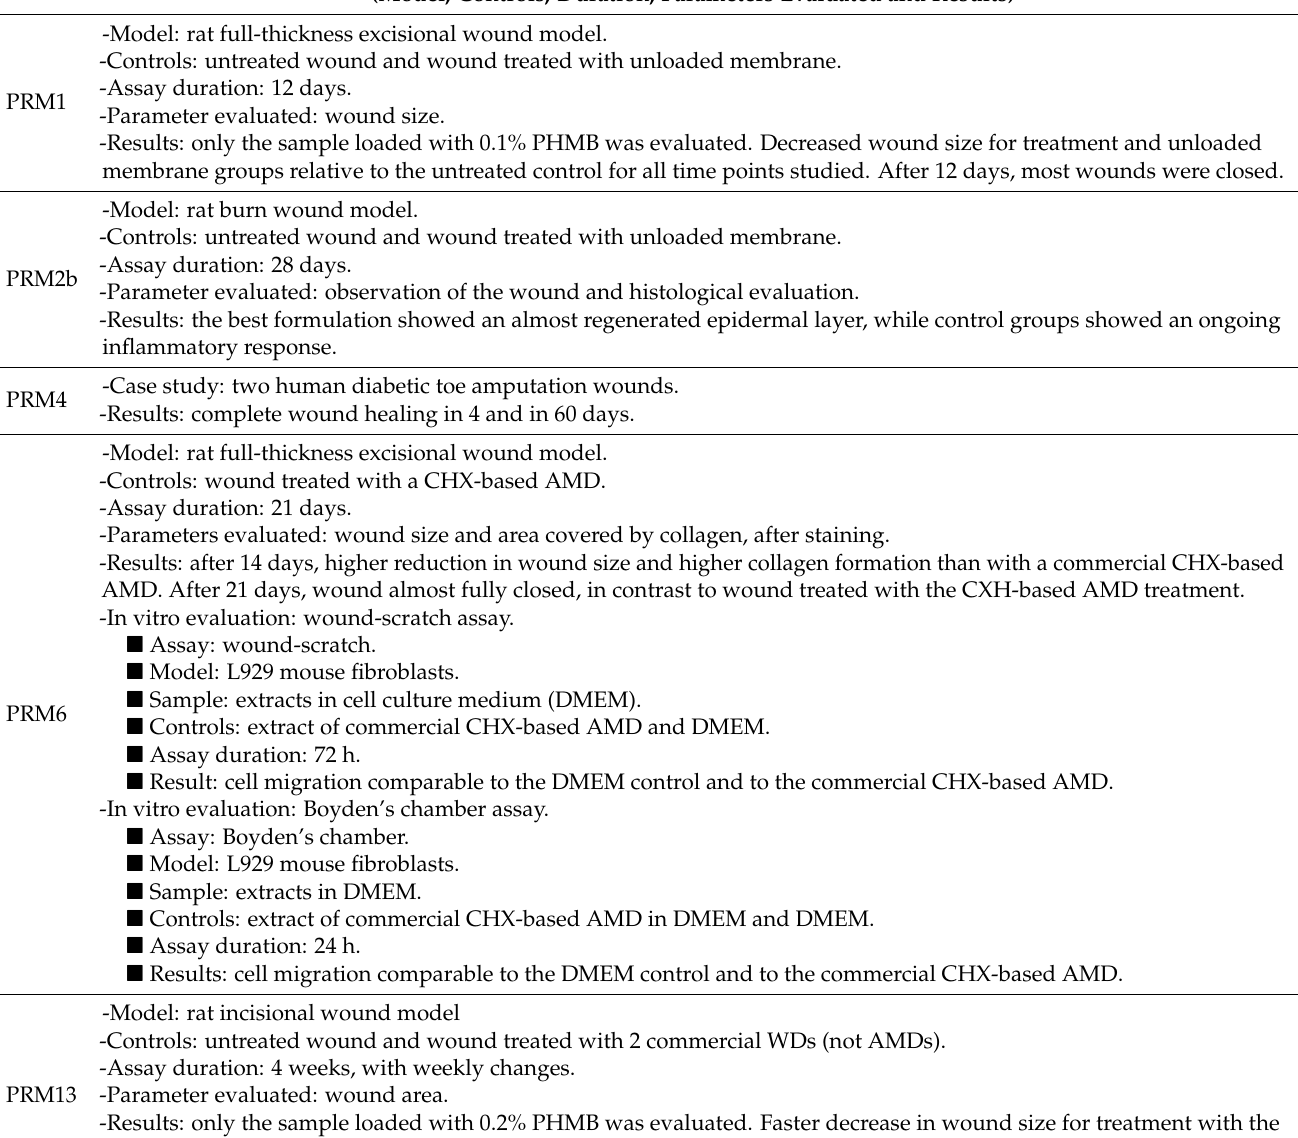
Table 11. In vitro and in vivo evaluation of wound-healing capacity of PHMB-releasing membranes (PRMs) developed for antimicrobial dressings (AMDs). Membrane IDs and corresponding biblio- graphic references are the same as in Table 3. 1. Wound-Healing